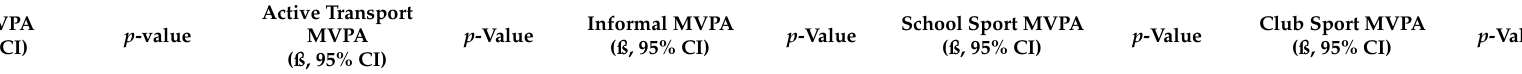
Table 4. Adjusted associations of perceived neighbourhood environmental attributes with physical activity domains of adolescents in urban South